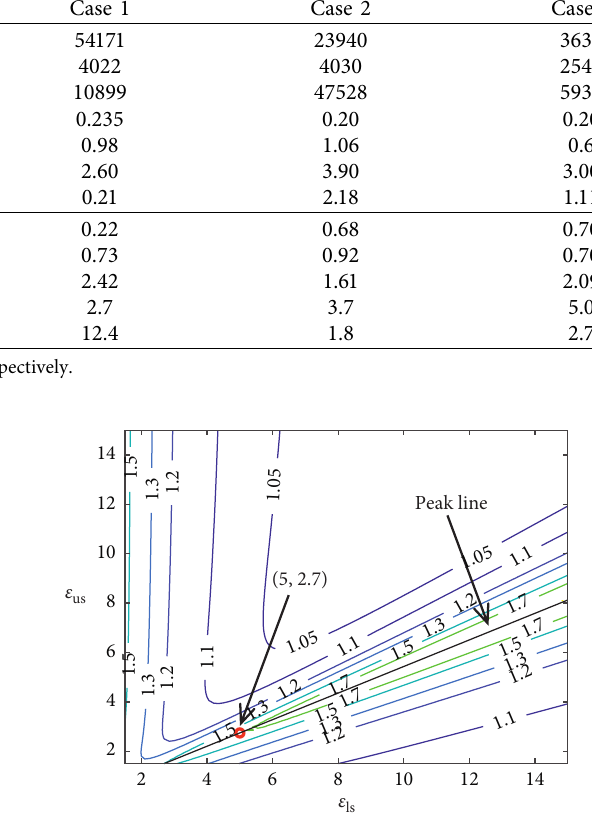
Figure 10: Contour plot of R a ui with various ε ls and ε us (Case 1).